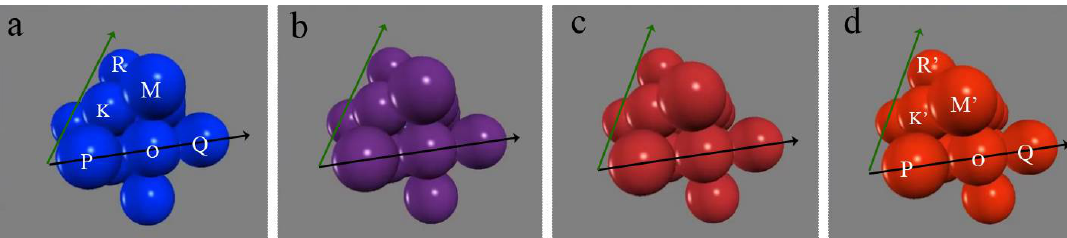
Figure 21. KS distortion explained with hard-spheres. The continuity is given by a unique parameter, the angle, β = ( PO , PK ) that changes from 60° (bcc) to 70.5° (fcc). Movie at http://lmtm.epfl.ch/research.